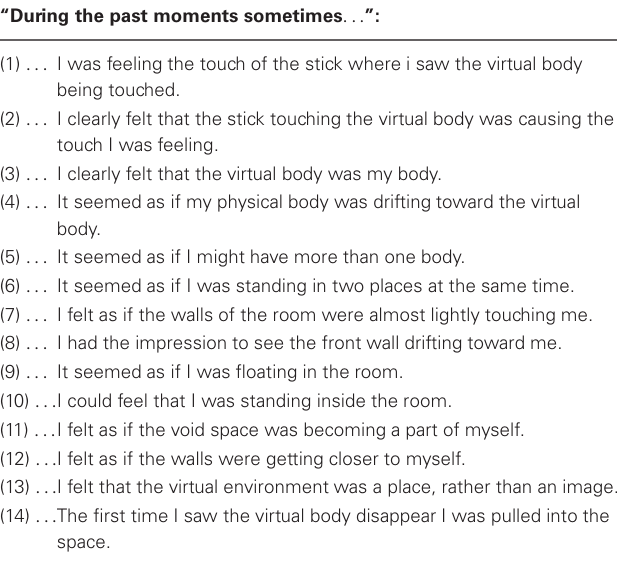
of the room (large or narrow) facing the front wall at a dis- Table 1 | The questionnaire completed after each experimental block. “During the past moments sometimes ...